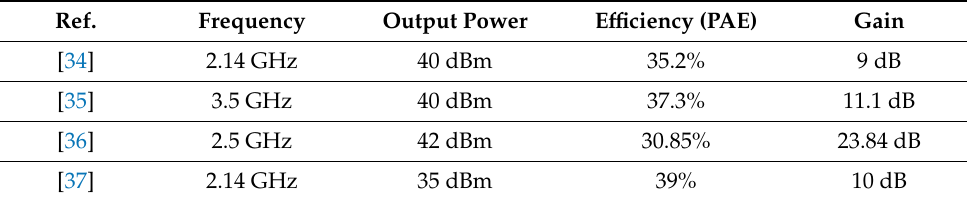
Table 3. Measured performance summary of similar topology